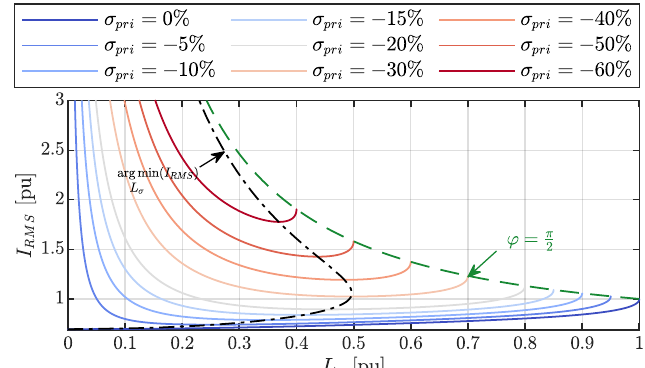
Figure 4. Dependency of the RMS value of the phase currents on the leakage inductance for different percentages of deviation in the primary side nominal dc-link voltage, σ pri , while the active power is kept constant at its nominal